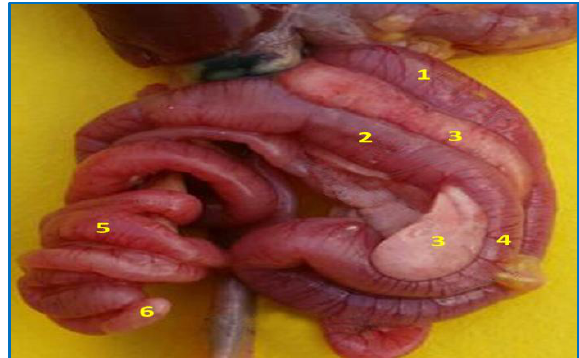
Figure, 3: parts of small intestine in kestrel (1) Descending limb,(2) Ascending limb, (3) pancreas, (4) duodenum, (5) jejunum, (6) Meckel's diverticulum.